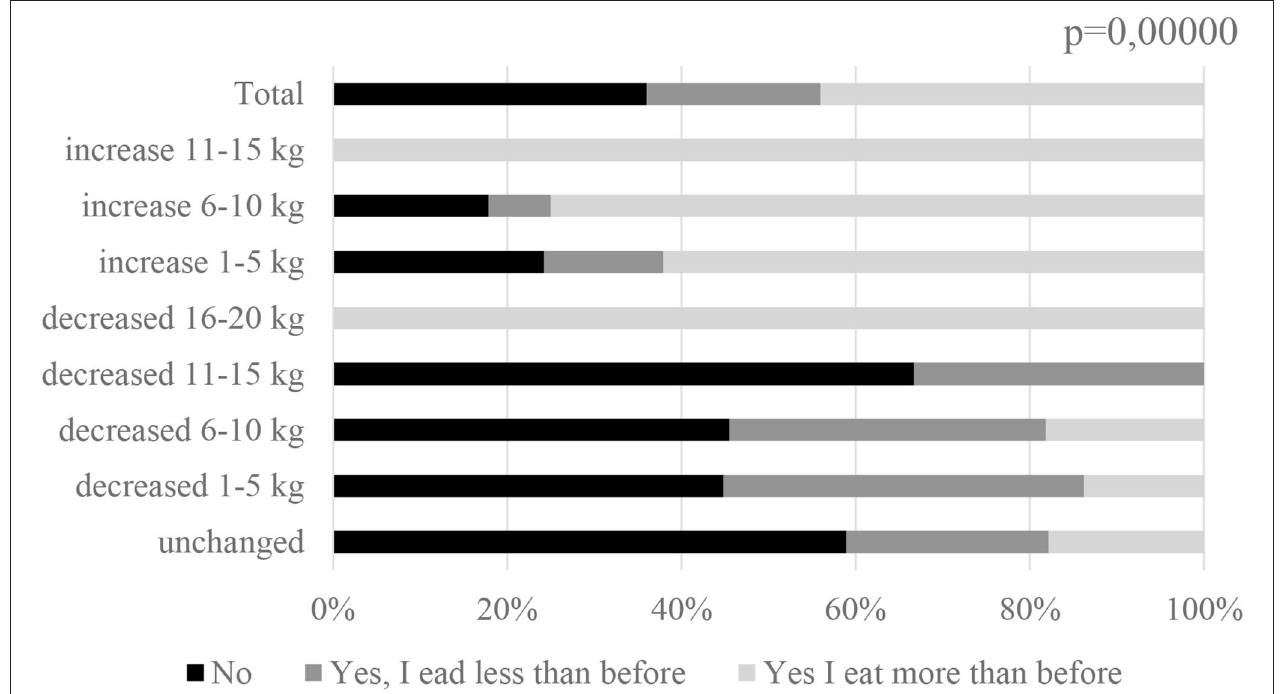
FIGURE 1 | Change in eating behavior vs. change in body weight among subjects n = 225.